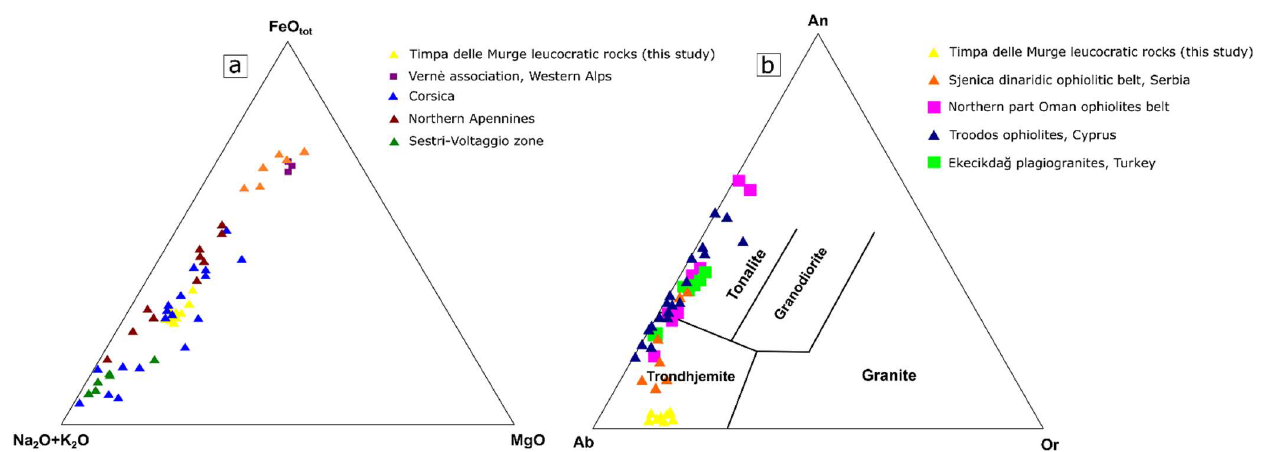
Figure 11. ( a ) AFM ternary diagram with compositional data for both leucocratic rocks of Timpa delle Murge and several Tethyan plagiogranites [15,17]; ( b ) Ab-An-Or ternary diagram for Timpa delle Murge leucocratic rocks and other Tethyan plagiogranites [1,18–21].